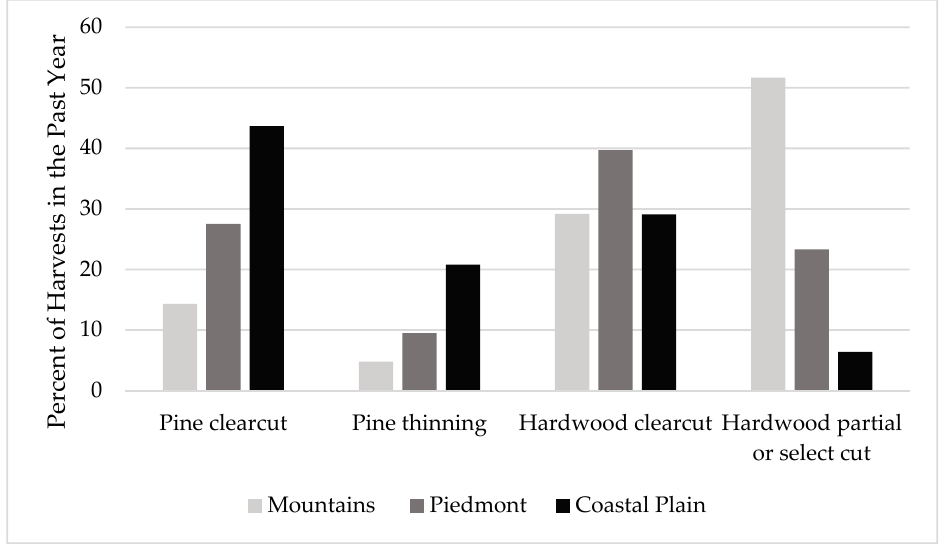
Figure 2. Reported type of harvests performed in the past year by physiographic region.